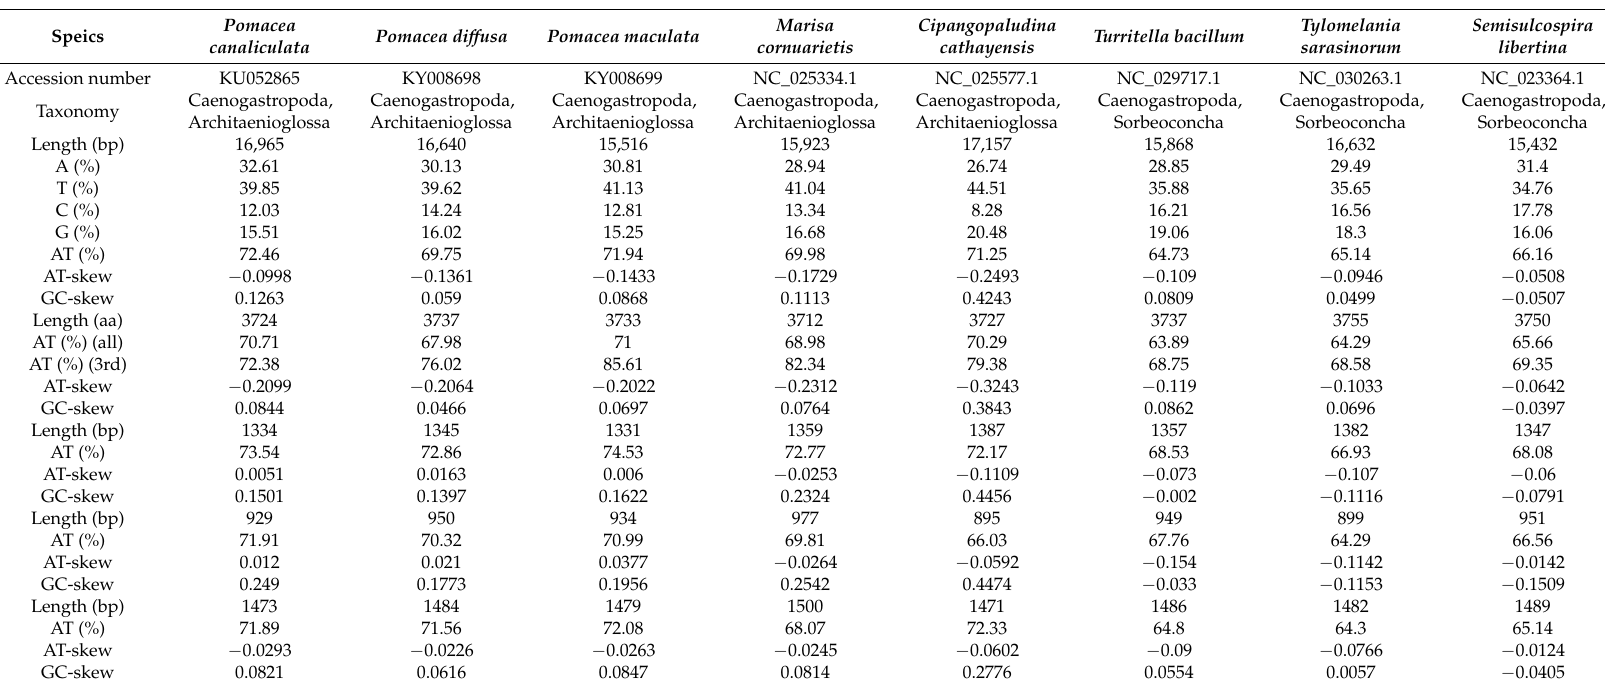
Table 2. Summary of the base composition of the mitogenomes for eight species of the orders Sorbeoconcha and Architaenioglossa in the Gastropoda.